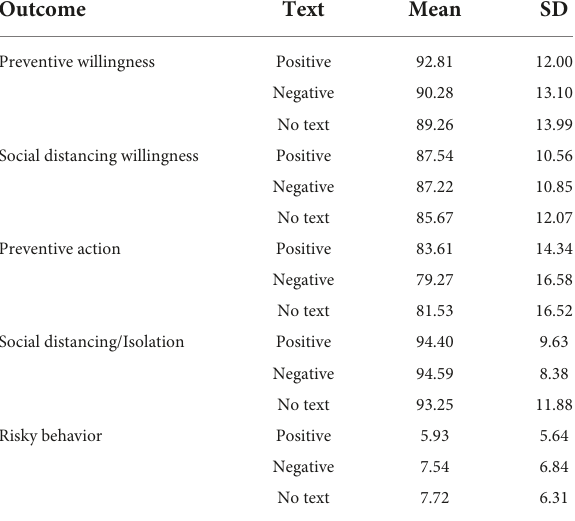
TABLE 1 Preventive willingness and actual behavior as a function of text condition.